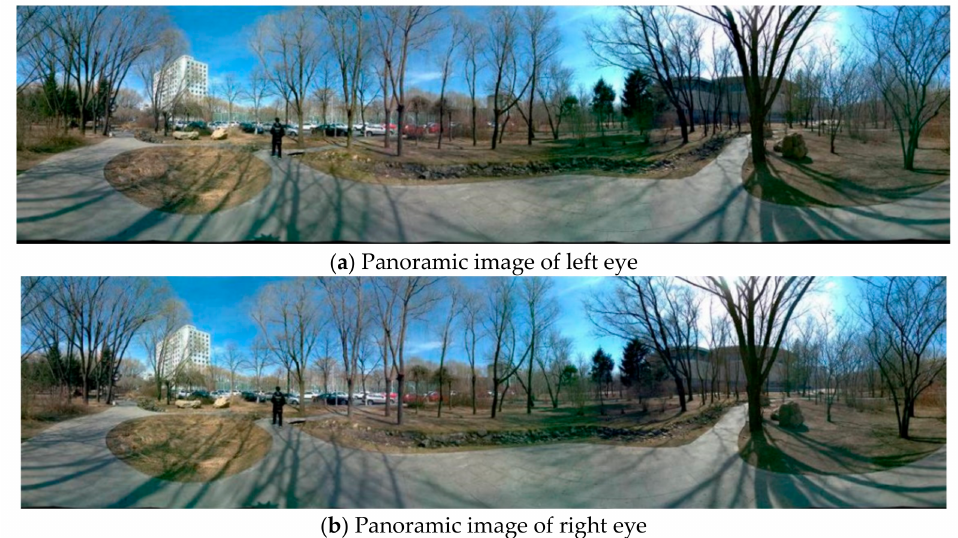
Figure 18. The left ( a ) and right eye ( b ) compose a stereoscopic panorama in good light.